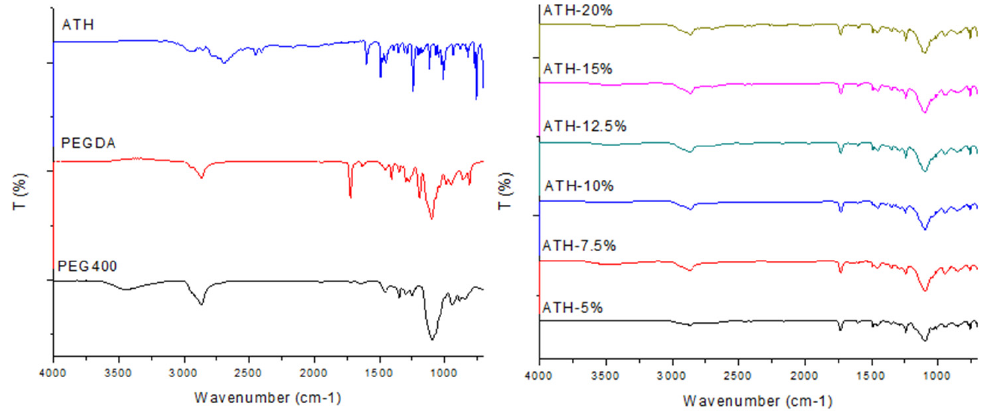
Figure 9. Fourier-transform infrared (FTIR) spectra of substances ( left ) and fabricated tablets ( right ).